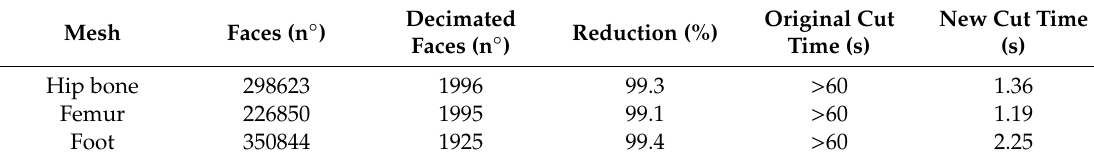
Table 2. Time comparison between original and decimated